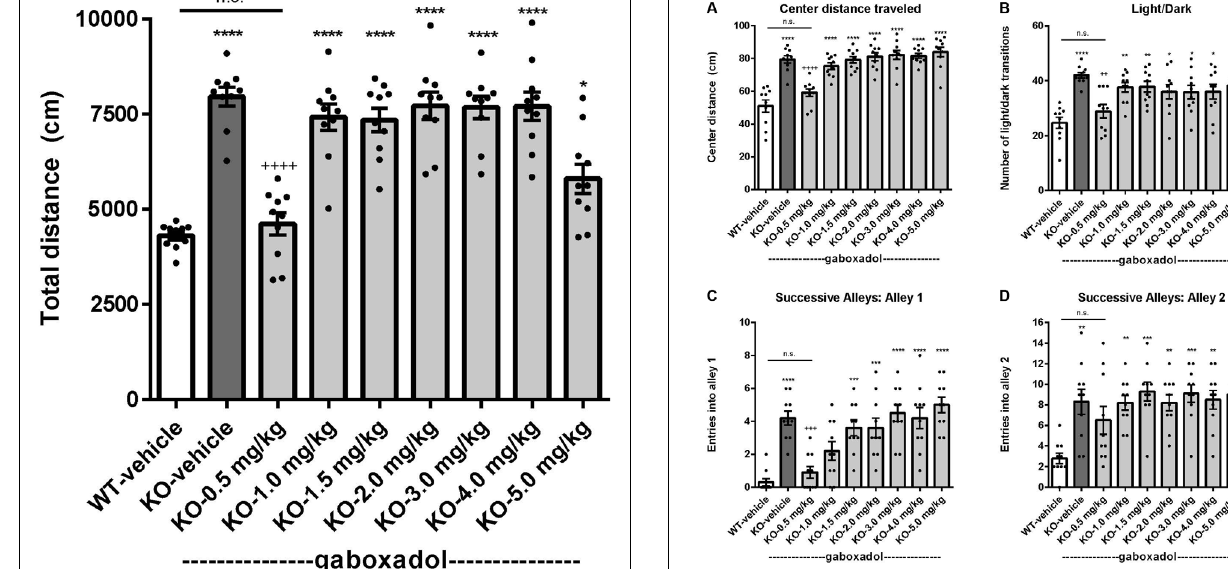
FIGURE 1 | Gaboxadol normalizes hyperactivity in Fmr1 KO2 mice. Total distance traveled for 30 min for wild-type-littermates (WT) mice treated with vehicle (white bar), Fmr1 KO2 mice treated with vehicle (knockout, KO dark gray bar) and Fmr1 KO2 mice treated with gaboxadol (KO-0.5–5.0 mg/kg, light gray bars). Bars are means ± SEM, dots are raw data from individual mice. ∗ p < 0.05, ∗∗∗∗ p < 0.0001 vs. WT-vehicle group; ns, not significant vs. WT-vehicle group; ++++ p < 0.0001 vs. Fmr1 KO2-vehicle group. N = 10 per group.